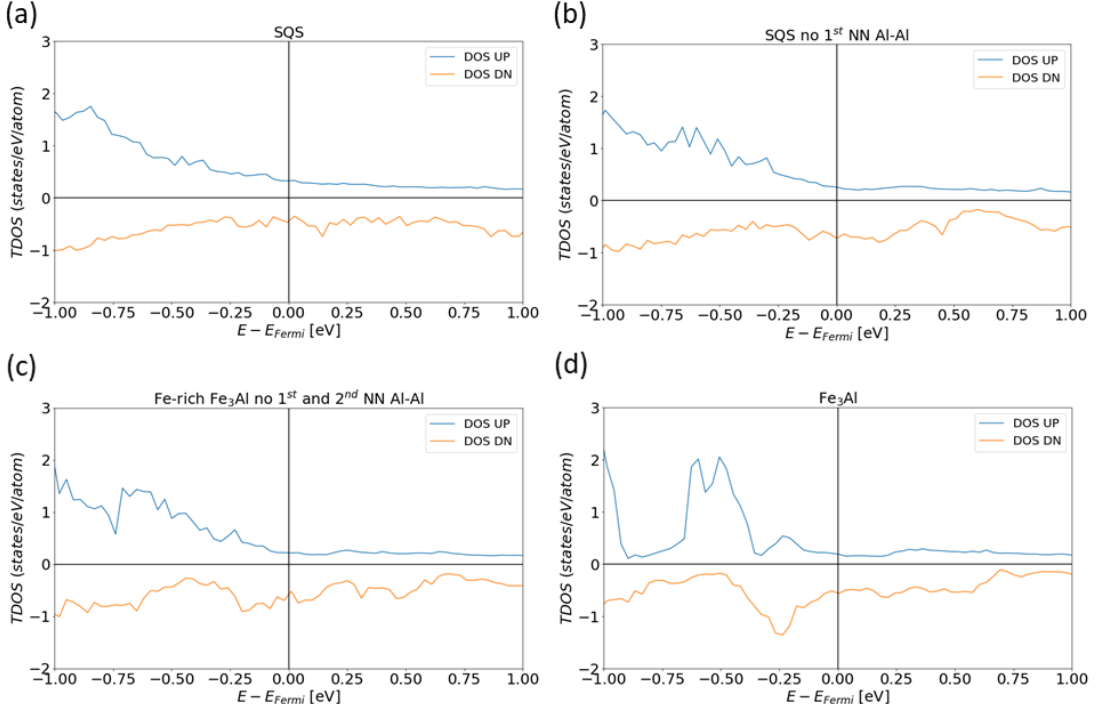
Figure 6. Calculated total densities of states (TDOS) in the case of the 32-atom supercells as models for individual phases: figures ( a – c ) are SQS models for the Fe-Al phase with different atomic arrangements and figure ( d ) for the Fe 3 Al intermetallic